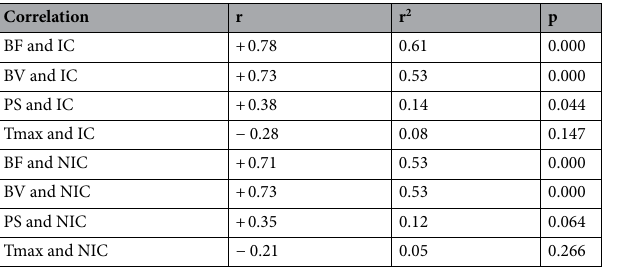
Table 4. Correlations of quantitative parameters between perfusion computed tomography and dual-energy computed tomography in patients with solitary pulmonary nodule (SPN). BF blood flow, BV blood volume, PS permeability surface area product, Tmax time-to-maximum of the tissue residue function, IC iodine concentration, NIC normalized iodine concentration: R, correlation coefficient; R 2 , square of the correlation coefficient; and P, statistical